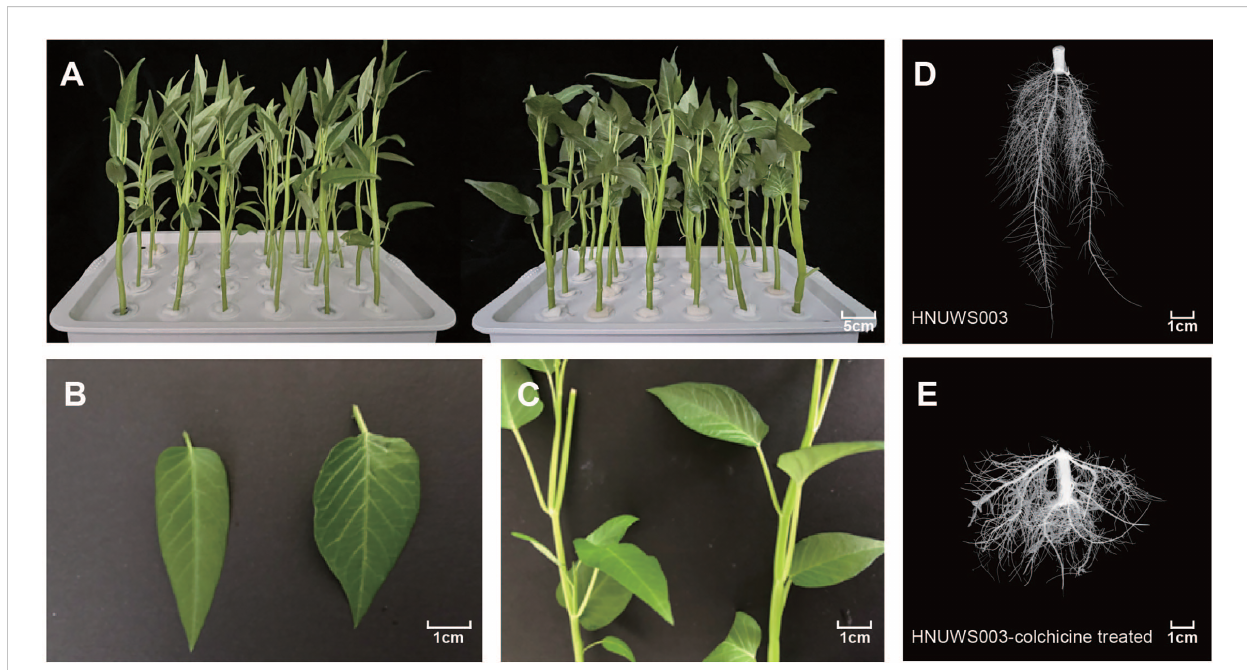
FIGURE 1 Morphological comparison of colchicine treated water spinach and its diploid parent. (A – C) Morphological comparison ( A : plants; B : leaf; C : stem; left: HNUWS003; right: HNUWS003-colchicine treated). (D) 2X water spinach root morphology. (E) colchicine treated water spinach root